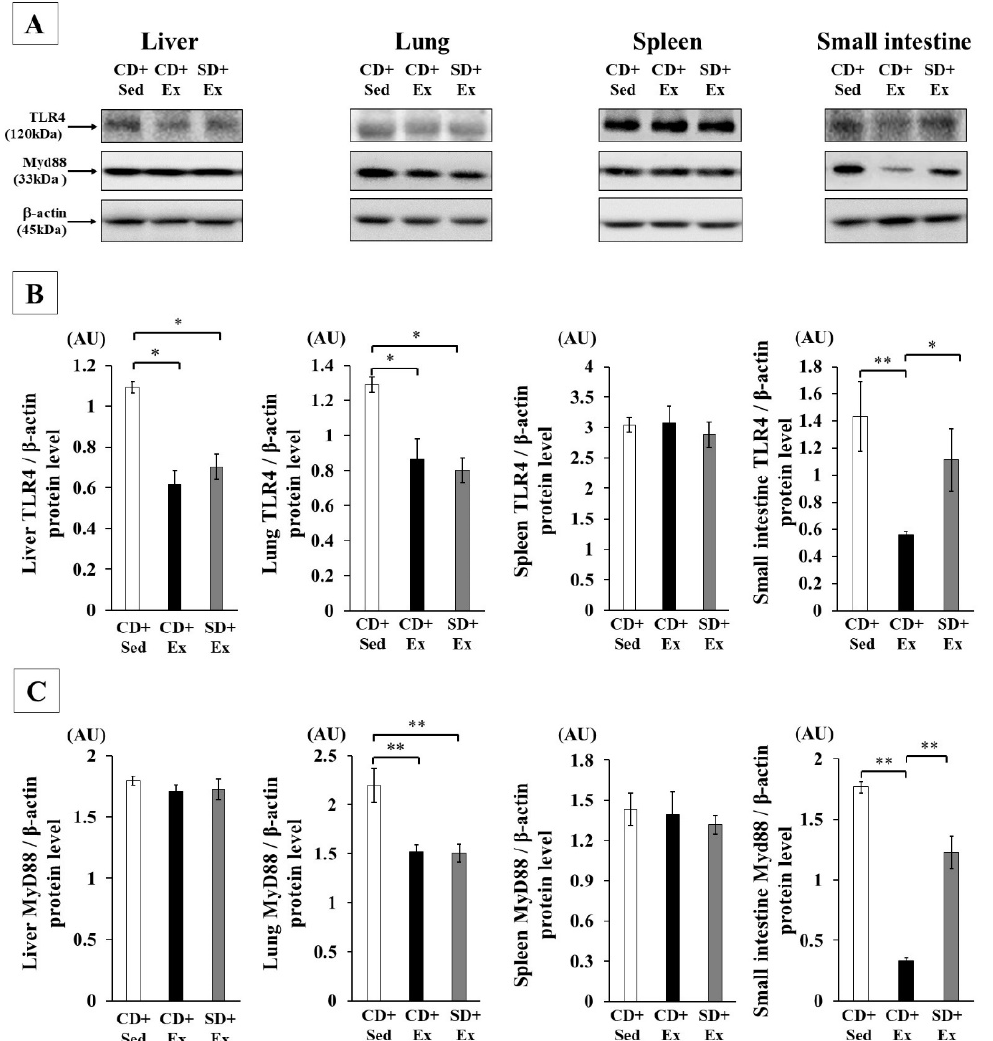
Figure 3. The effect of exhaustive exercise and Sparassis crispa intake on expression of TLR4 and MyD88 proteins in the liver, lung, spleen and small intestine of mice. Representative immunoblotting image and histograms of the levels of TLR4 and MyD88 are shown ( A ). β -actin protein expression was used as an internal control for normalizing the protein expression of TLR4 ( B ) and MyD88 ( C ) in the liver, lung, spleen, large intestine and small intestine. AU, arbitrary units. Values are means ± SEM. * p < 0.05, ** p < 0.01.